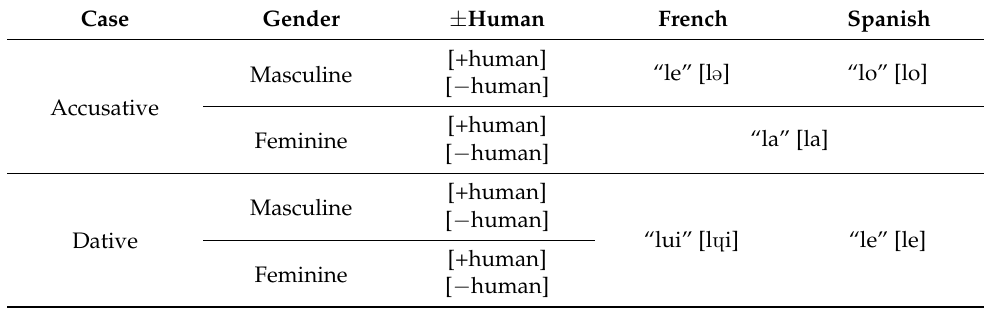
Table 1. Third-person singular accusative and dative object clitics in French and Spanish. 4